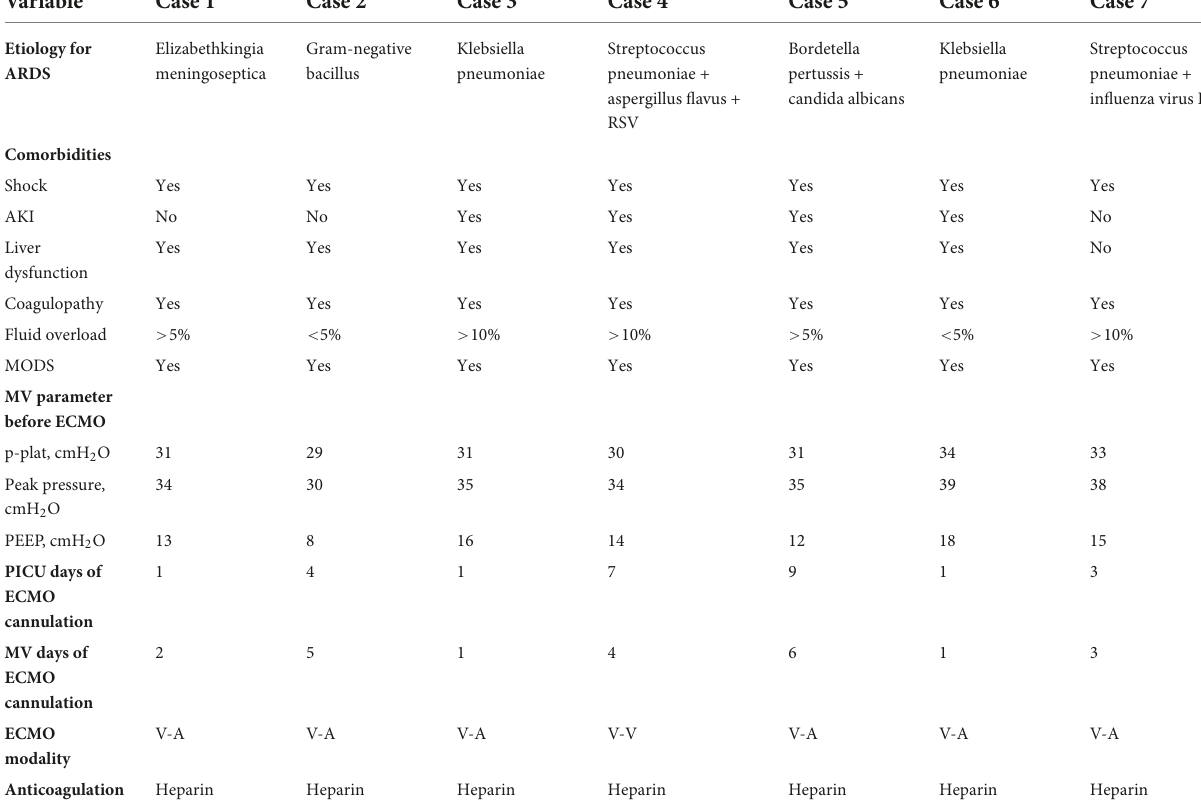
TABLE 1 Baseline characteristics of patients at initial ECMO support.